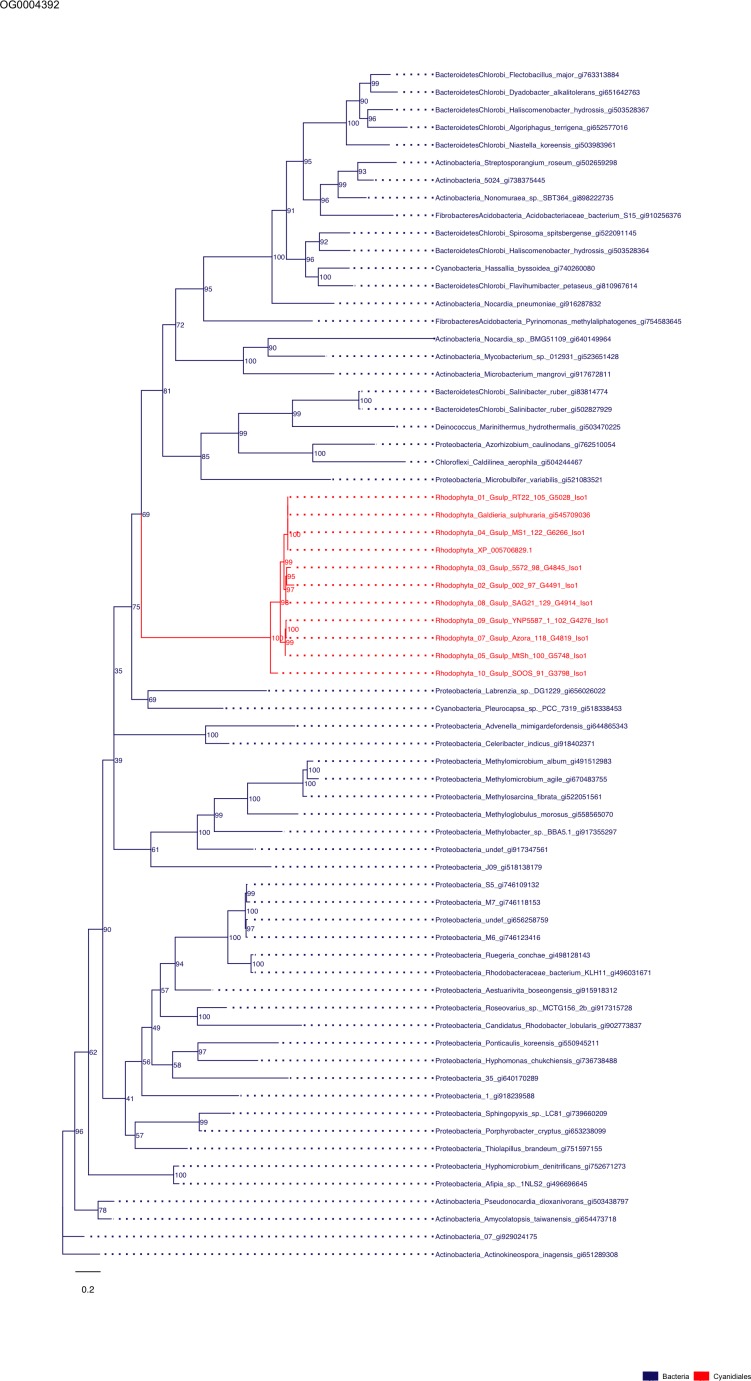
Sequence tree of orthogroup OG0004392.The tree is based on amino acid sequences. Archaea (yellow), Bacteria (blue), Cyanidiales (red), Eukaryotes including other red algae (green). Branches containing Cyanidiales sequences are highlited in red.